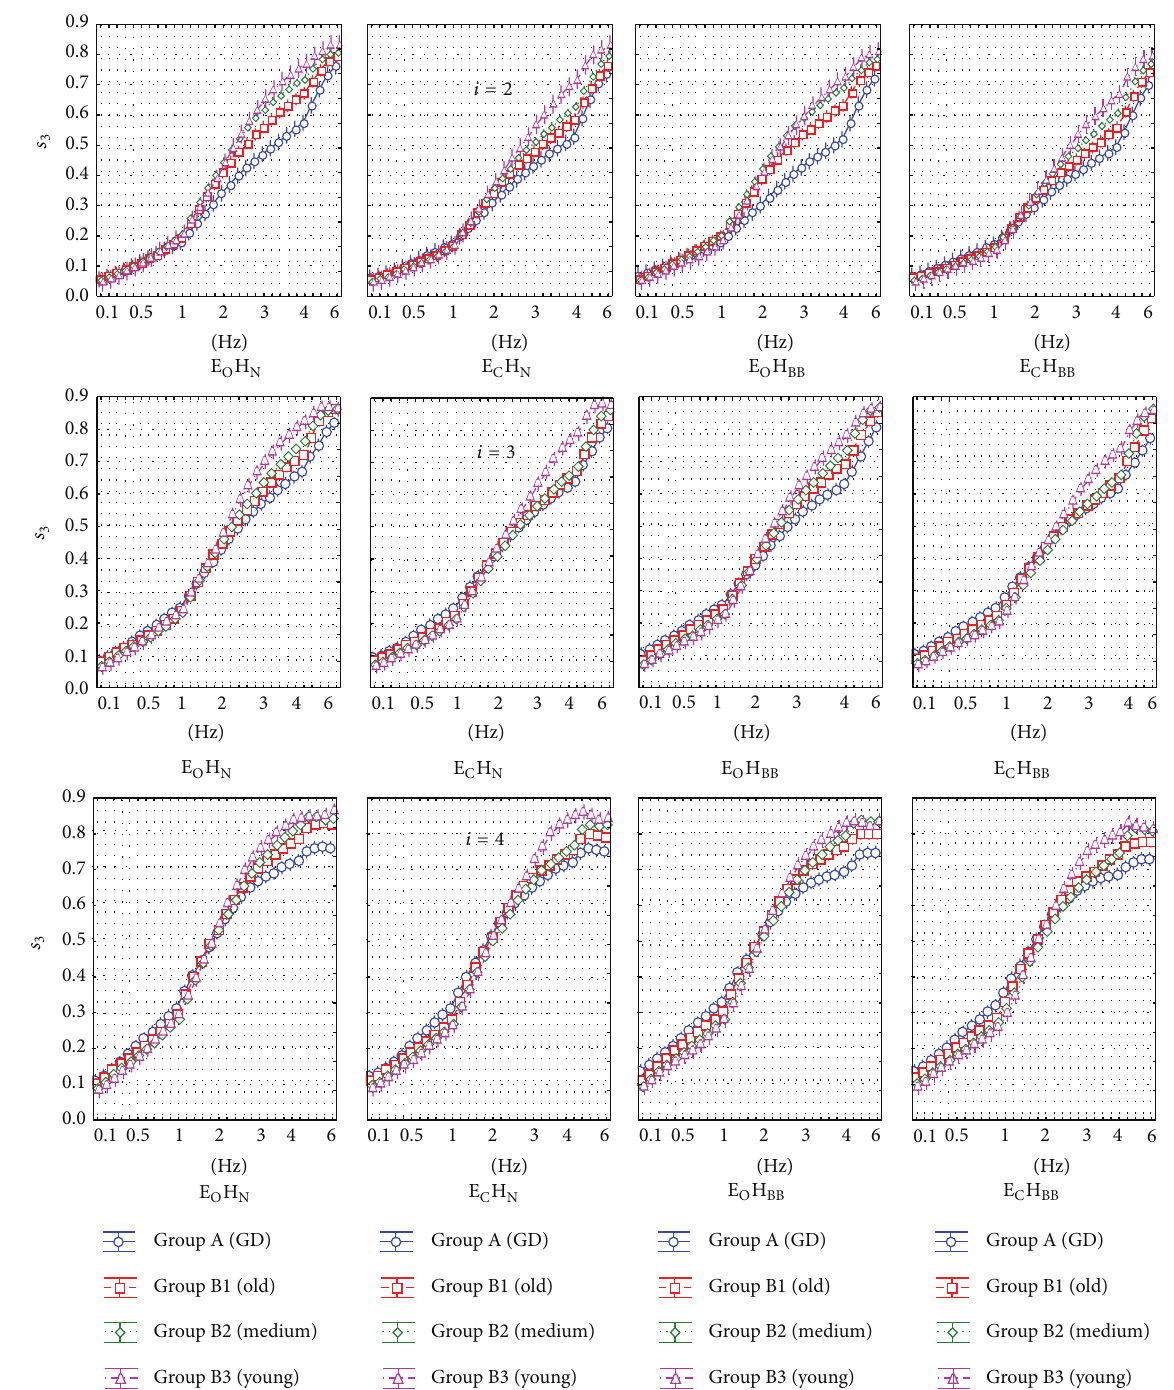
Figure 4: The detailed 𝑠 3 values obtained in successive patient groups for different registration methods. Three rows represent different number of columns ( 𝑖 ) in PCA